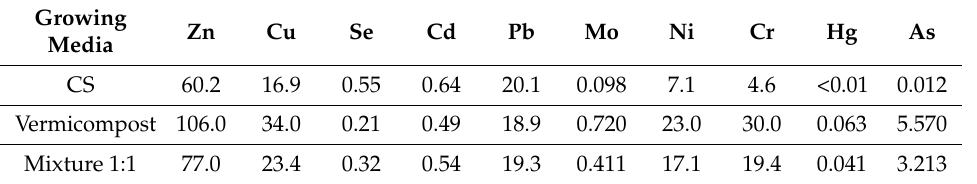
Table 2. Total concentrations (mg/kg) of the microelements (Zn, Cu, Se, Mo, Ni) and harmful heavy metals (Cd, Pb, Cr, Hg and As) in commercial substrate (CS), vermicompost and mixture